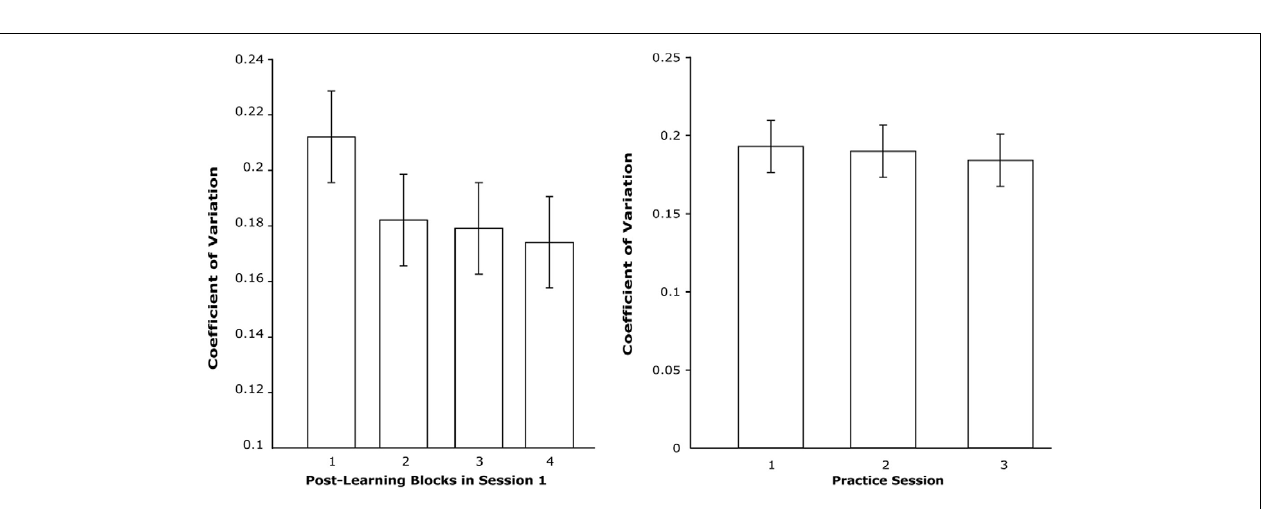
allowing for small variations in peak latency across individuals and